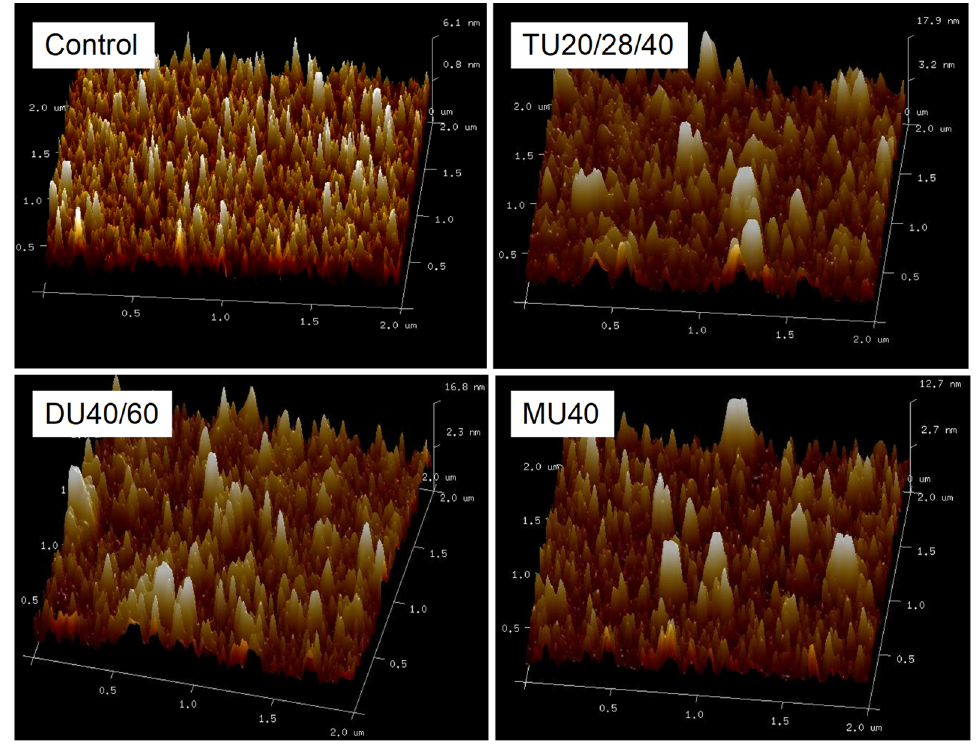
Figure 8. Atomic force microscopy (AFM) micrographs of potato protein treated with online-US/T40/pHS at the frequency of TU20/28/40, DU40/60, and MU40 kHz.